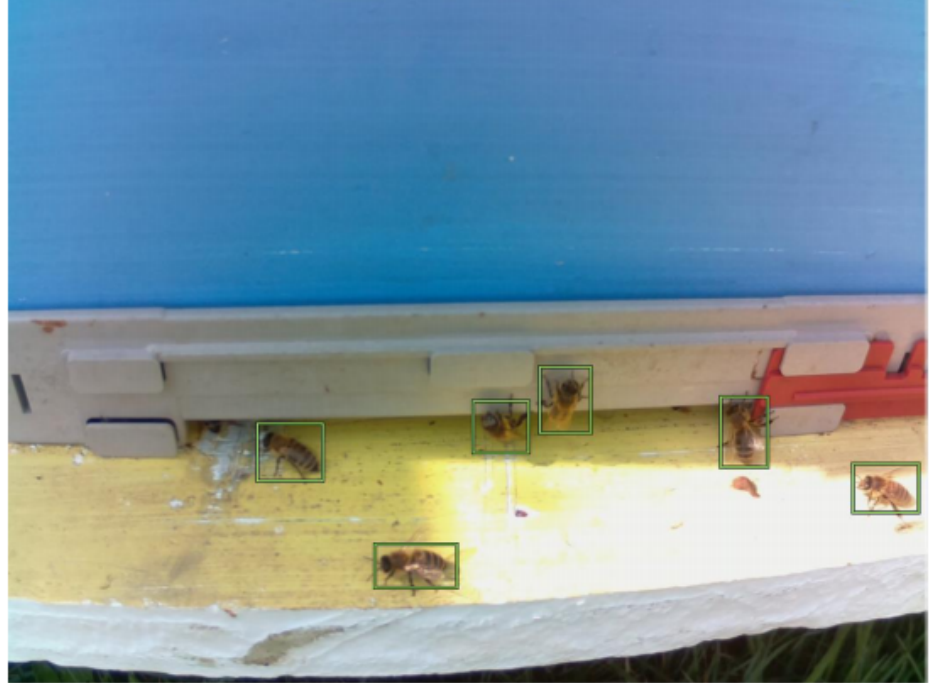
Figure 5. A sample picture extracted from the video data stream with bees marked with rectangles (frames) used for training the model of bee